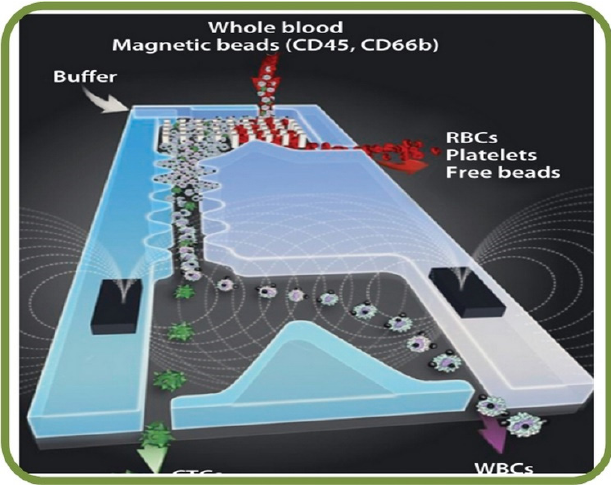
Figure 15. Microfluidic blood sorting devices. Biomimetic microfluidic chip for separating malaria- infected RBCs from healthy RBCs [264].